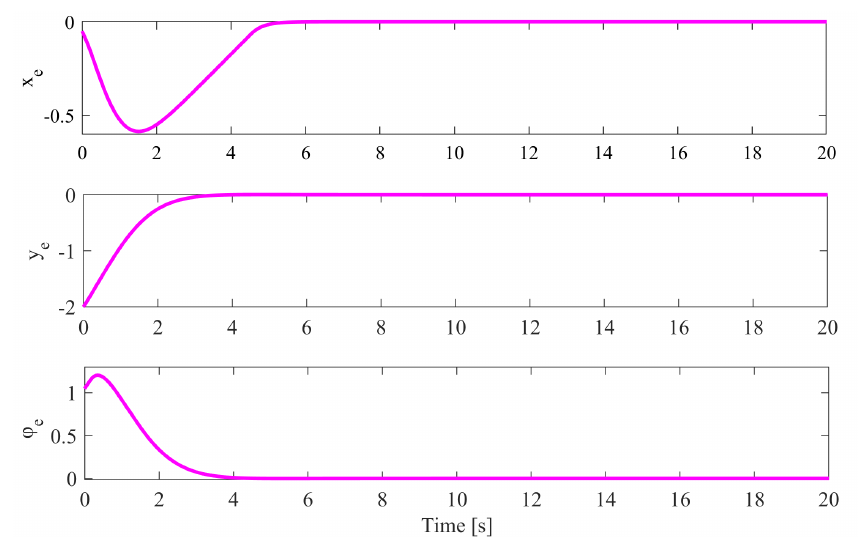
Figure 12. Longitudinal error, lateral error and yaw angle error.